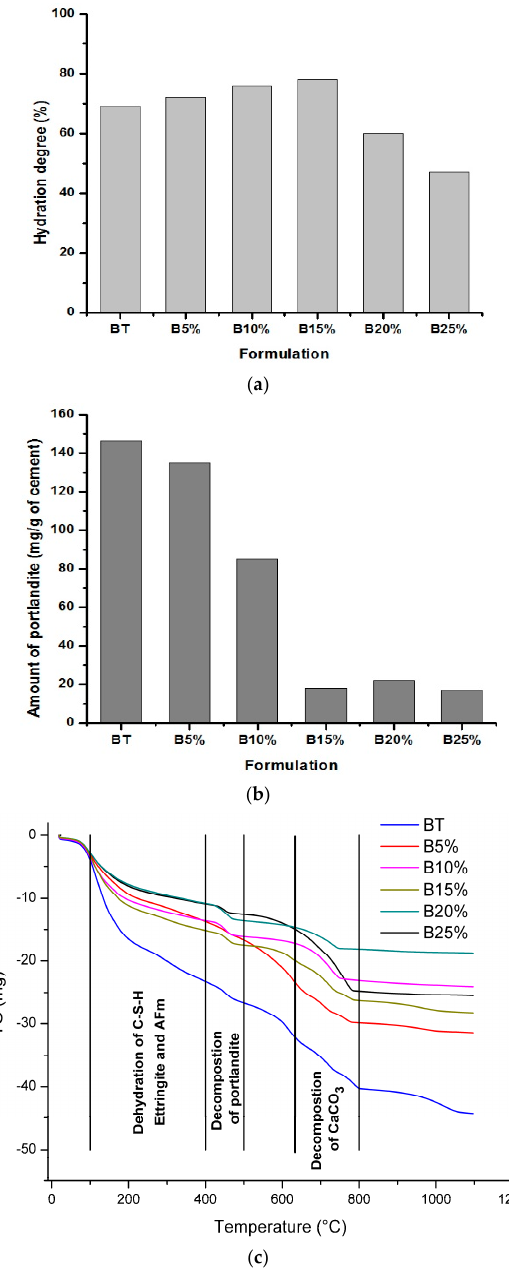
Figure 4. ( a ) Hydration degree, ( b ) amount of portlandite at 28 days and ( c ) thermogravimetric (TG) curves of studied concretes. The histogram of hydration degrees given in Figure 4a coincides with that of me- chanical strengths (see Figure 3). It can be seen that the hydration degree of materials con- taining percentage less than 15% of glass powder (i.e., 5%, 10% and 15%) is higher than that of reference concrete. However a slight increase in the hydration degree was observed